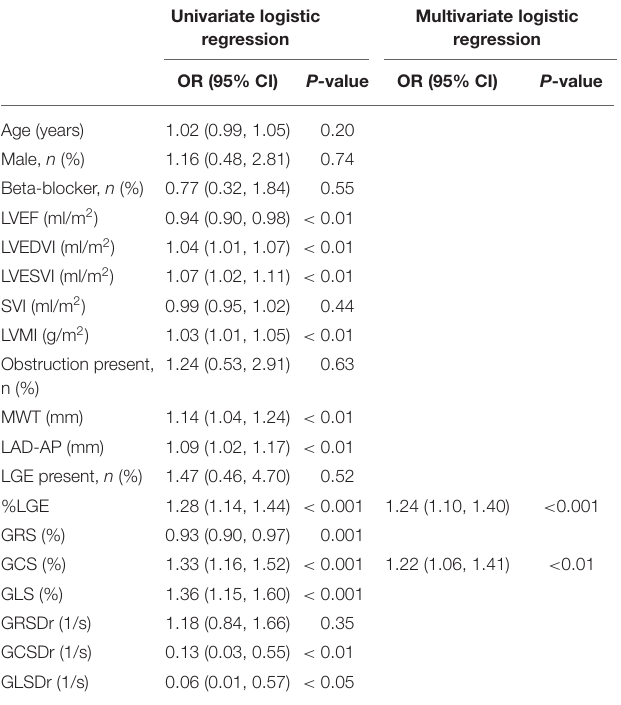
TABLE 3 | Univariate and multivariate logistic regression analysis for predictors of VAs in HCM patients. Univariate logistic regression